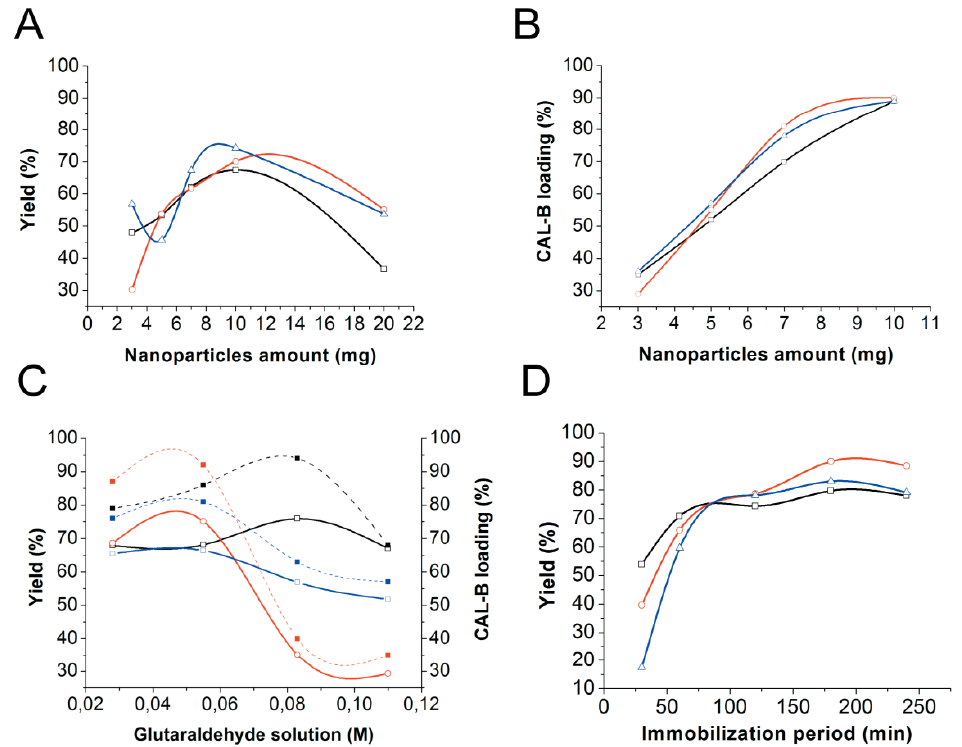
Figure 2. Analysis of the parameters evaluated in the immobilization protocol. ( A ) Effect of the amount of nanoparticles used; ( B ) Load of immobilized CAL-B on the amount of magnetic nanoparticles used; ( C ) Effect of the glutaraldehyde concentration used in the reaction yield (left axis) and in CAL-B loading (right axis- dotted lines) and ( D ) effect of the immobilization time. NP-ImS4/CAL-B (black line, □), NP-ImS10/CAL-B (red line, ○ ) and NP-ImS18/CAL-B (blue line, ). (cid:35)